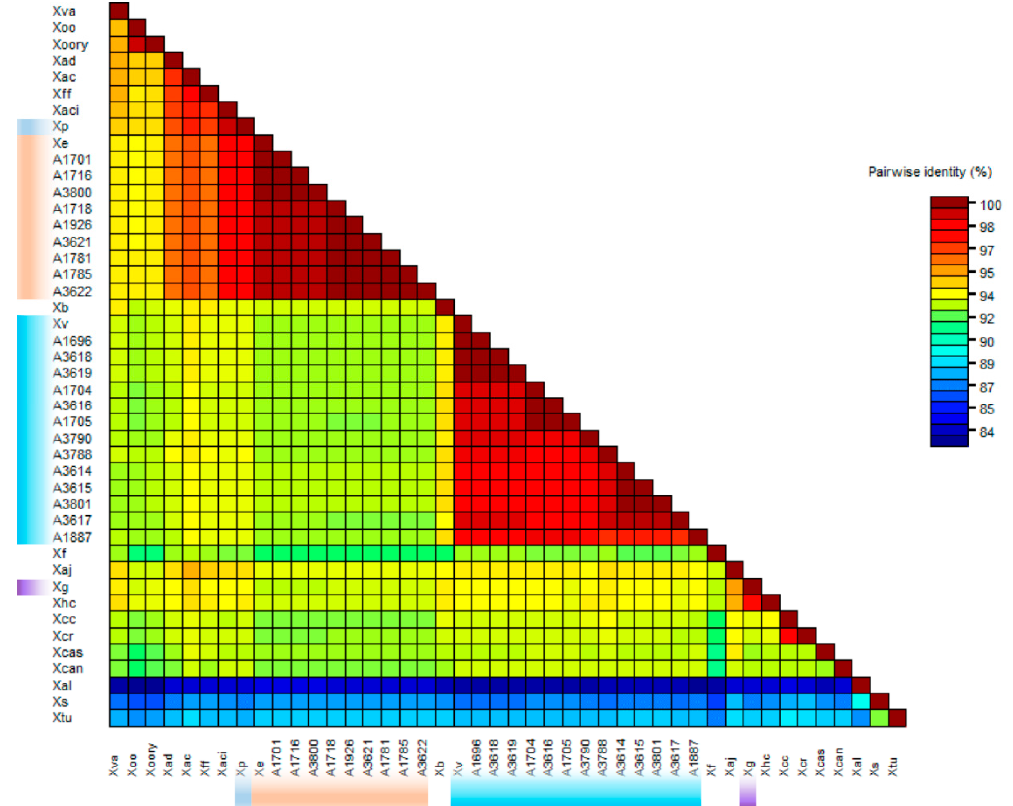
Figure 3. Color-coded matrix showing pairwise percentage identity of Xanthomonas euvesicatoria , X. vesicatoria with other species of Xanthomonas for chromosomal replication initiator factor ( dnaA ), type I glyceraldehyde-3-phosphate dehydrogenase ( gapA ), DNA topoisomerase (ATP-hydrolyzing) subunit B ( gyrB ), hydroxymethylbilane synthase ( hmbs ), and pyruvate dehydrogenase ( pdg ) genes. The information about the strains is provided in Table 1.